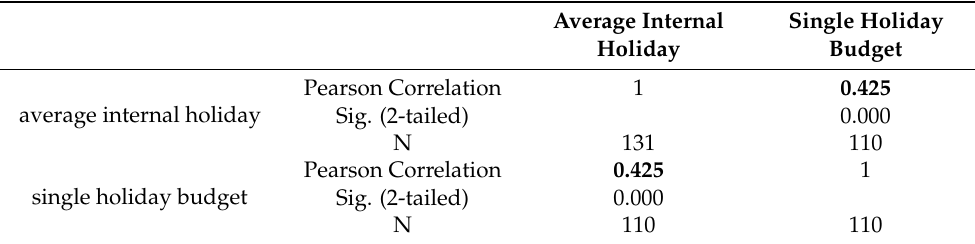
Table 4. Positive link, of medium intensity, between the duration of a holiday in the country and the allotted budget per stay.